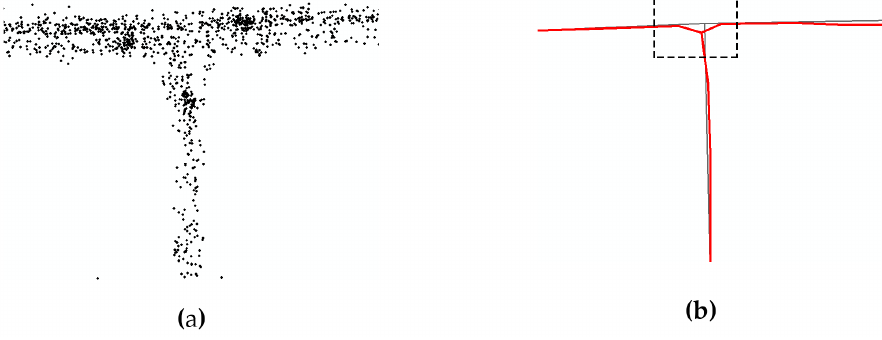
Figure 3. The intersection position deviation and road segments around the intersection are distorted, which connect directly with the end nodes of the road around the T-intersection. ( a ) The original GNSS input points; ( b ) T-intersection directly connected by road centrelines.